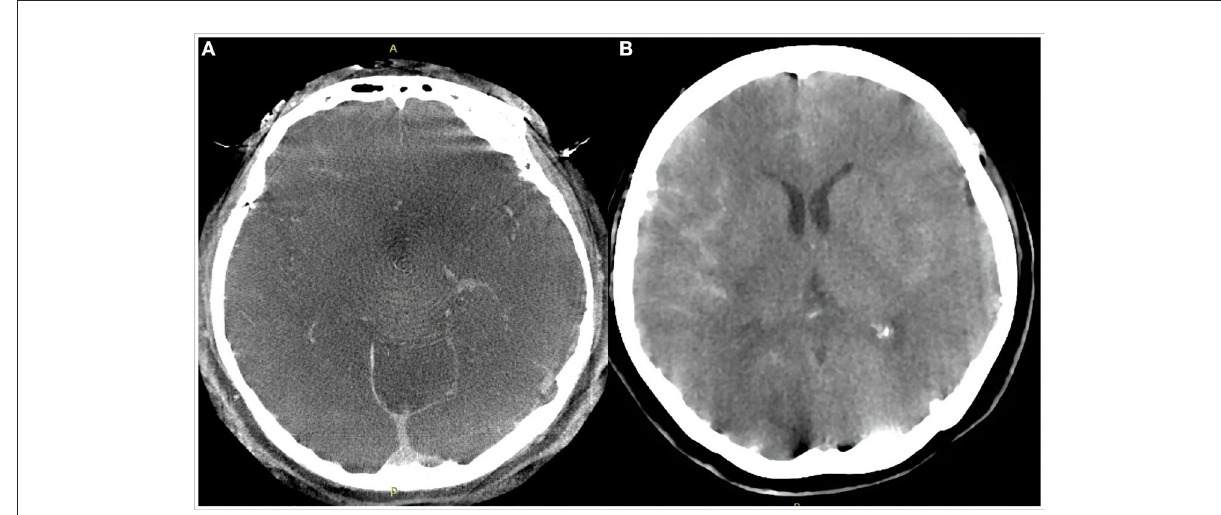
FIGURE2 Dyna computed tomography immediately after the procedure (A) showed no subarachnoid hemorrhage or intracerebral hemorrhage. Emergency head computed tomography 11h after the procedure (B) showed a small amount of hemorrhage in the Sylvian cistern, anterior interhemispheric cistern, and lateral